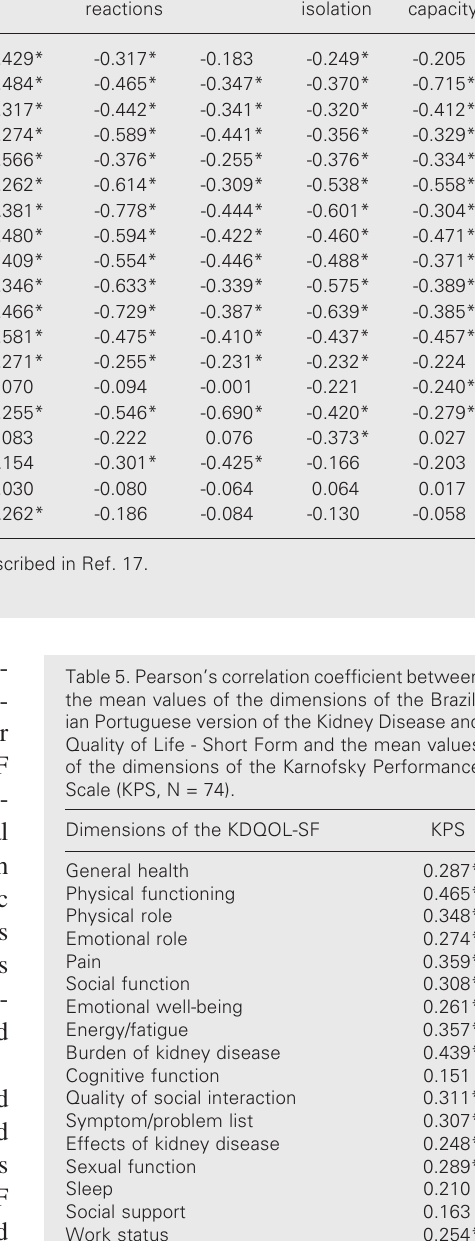
Table 4. Pearson’s correlation coefficient between the mean values of the dimensions of the Brazilian Portuguese version of the Kidney Disease and Quality of Life - Short Form and the mean values of the dimensions of the Nottingham Health Profile (N = 74). Dimensions of the KDQOL-SF